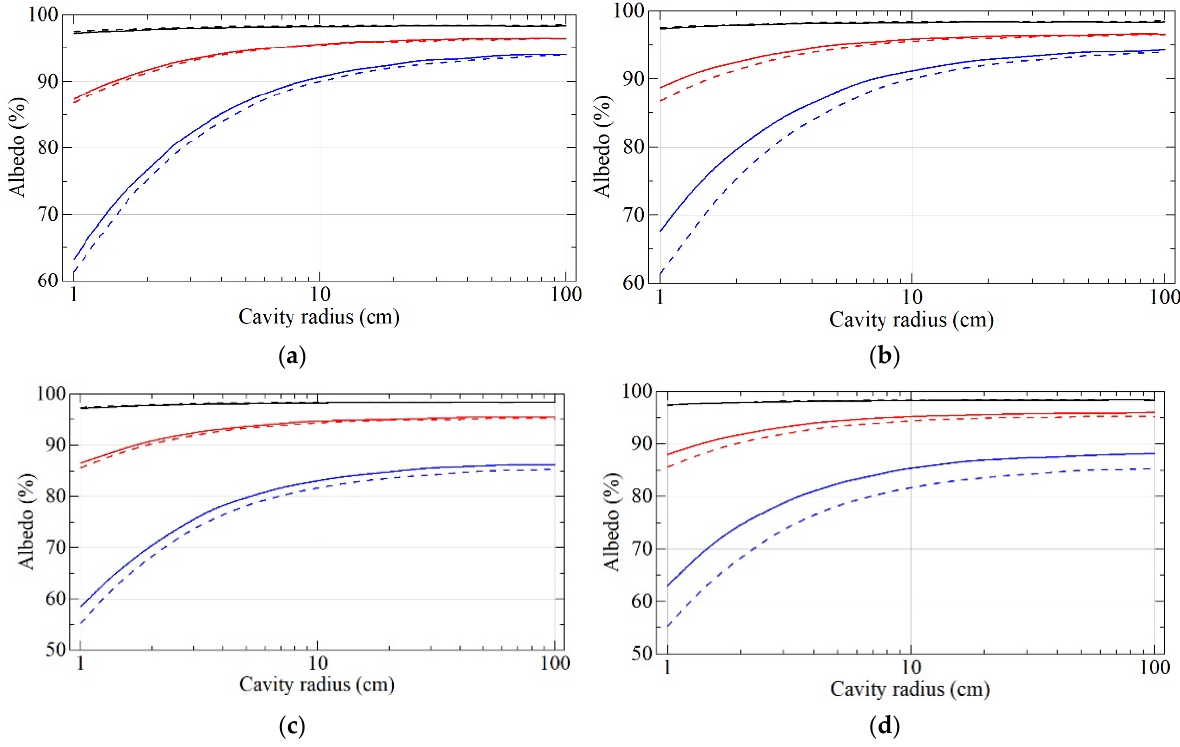
Figure 9. Neutron albedo for the velocities of 50 m/s (black lines), 100 m/s (red lines), and 150 m/s (blue lines) for S-DNDs (solid lines) and DF-DNDs (dashed lines) versus the cavity radius. ( a ) A powder layer of infinite thickness; the density is 0.56 g/cm 3 for both samples. ( b ) A powder layer of infinite thickness; the density is 0.56 g/cm 3 for DF-DNDs, and it is 0.67 g/cm 3 for S-DNDs. ( c ) A powder layer with the thickness of 3 cm; the density is 0.56 g/cm 3 for both samples. ( d ) A powder layer with the thickness of 3 cm; the density is 0.56 g/cm 3 for DF-DNDs, and it is 0.67 g/cm 3 for S-DNDs.